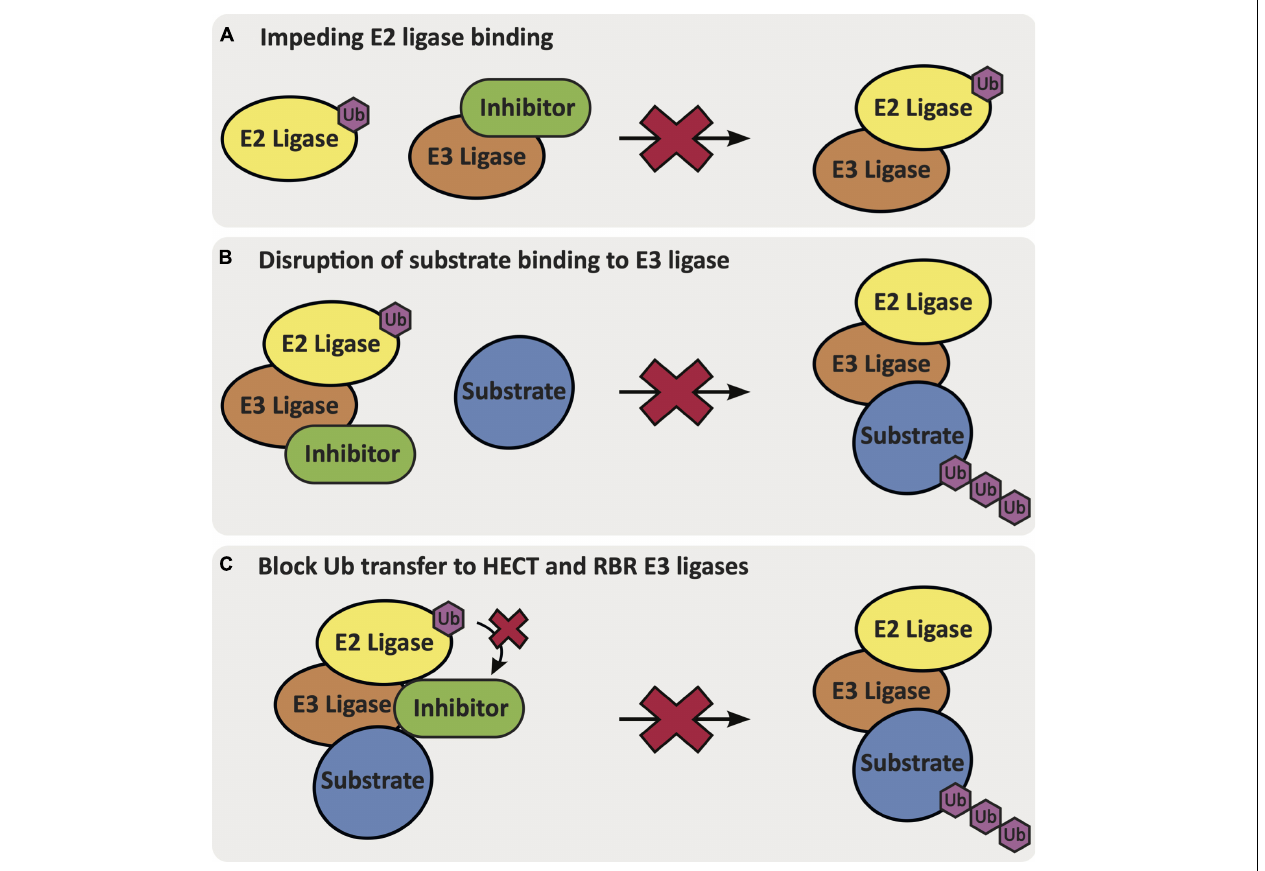
FIGURE 4 | The mechanisms via which an inhibitor binds and inhibits E3 ligase function: (A) impeding E2 ligase binding to the E3 ligase, (B) disruption of native substrate binding to the E3 ligase, or (C) blocking Ub transfer from the E2 ligase onto the HECT or RBR E3